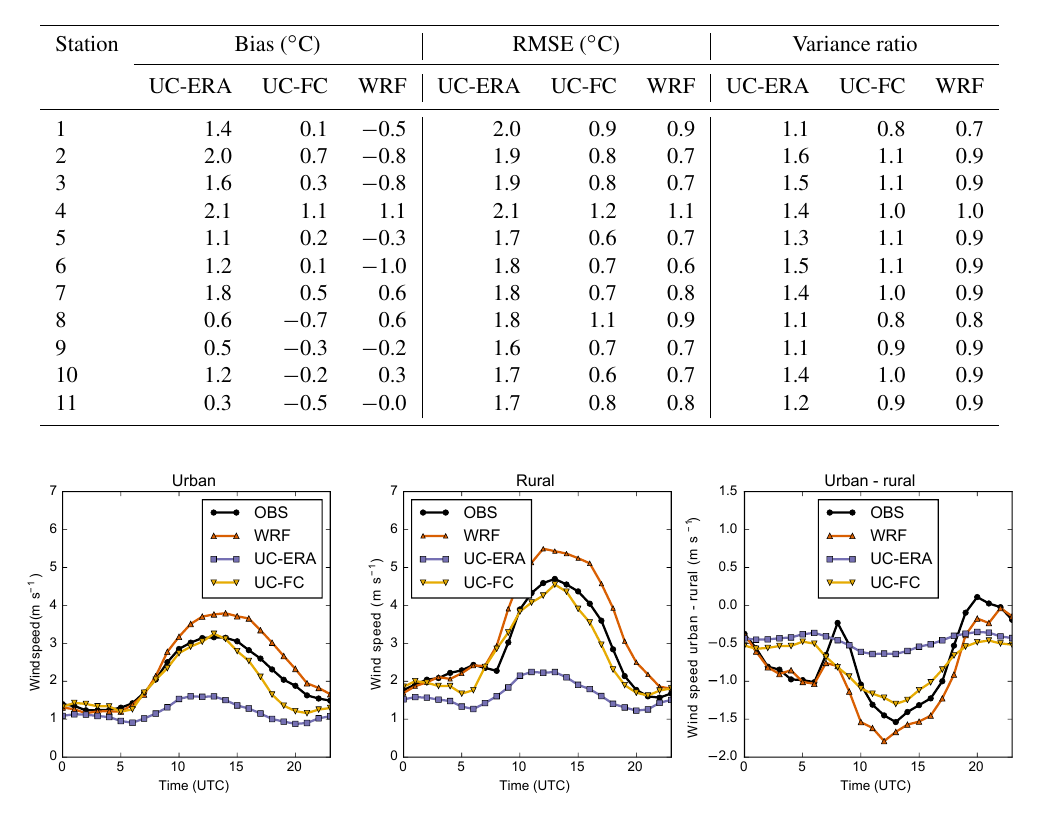
Table 1. Scores of daily mean 2m temperature for the UC-ERA, UC-FC and WRF simulations and the 11 stations depicted in Fig. 1. The scores are: Mean bias (model–observed), root mean squared error (RMSE), and variance ratio (i.e. the variance of the model divided by the variance of the station).